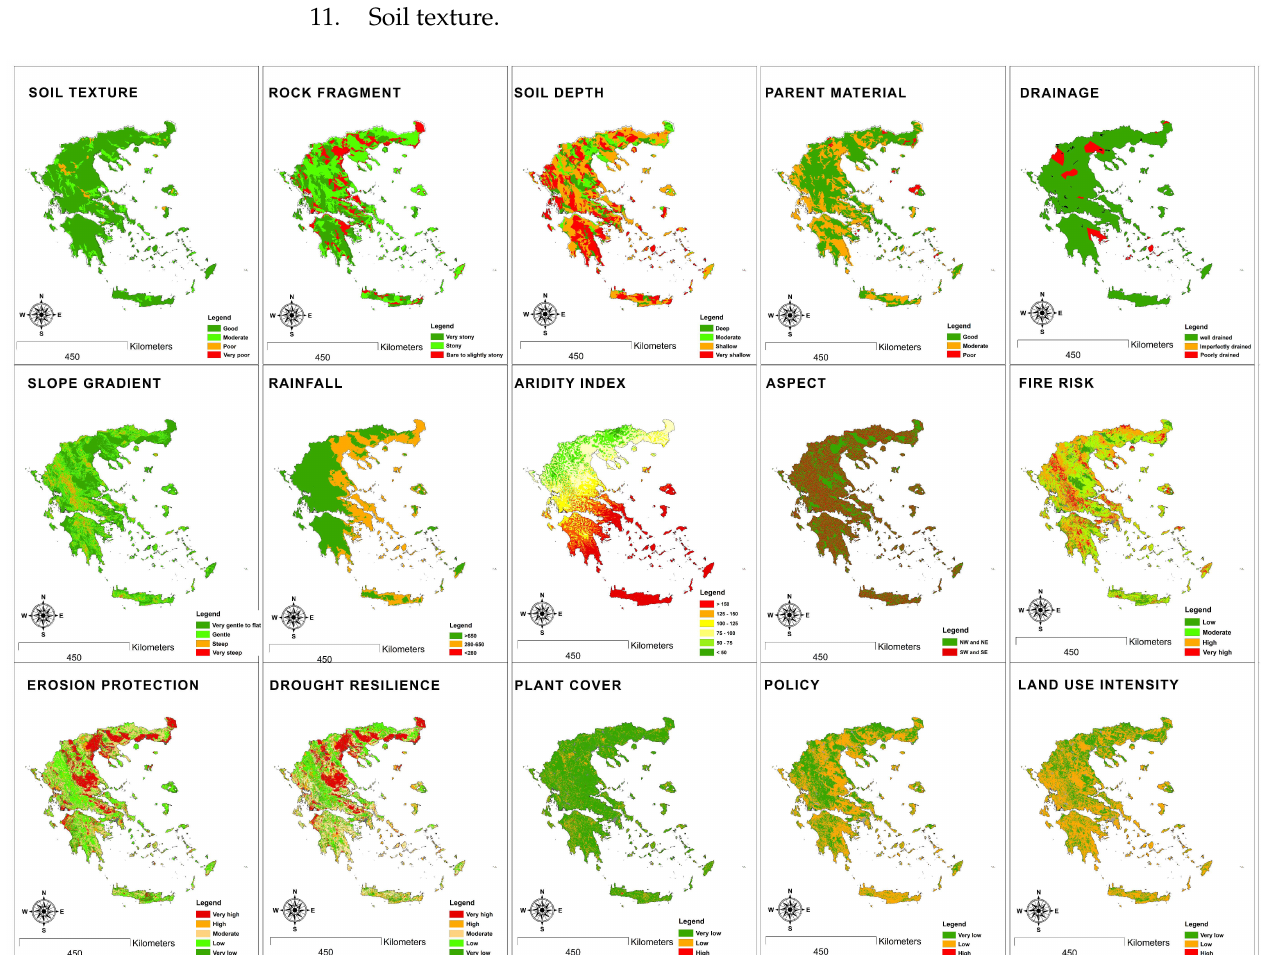
Figure 4. Examined indicators of ESAI for WLDI development and